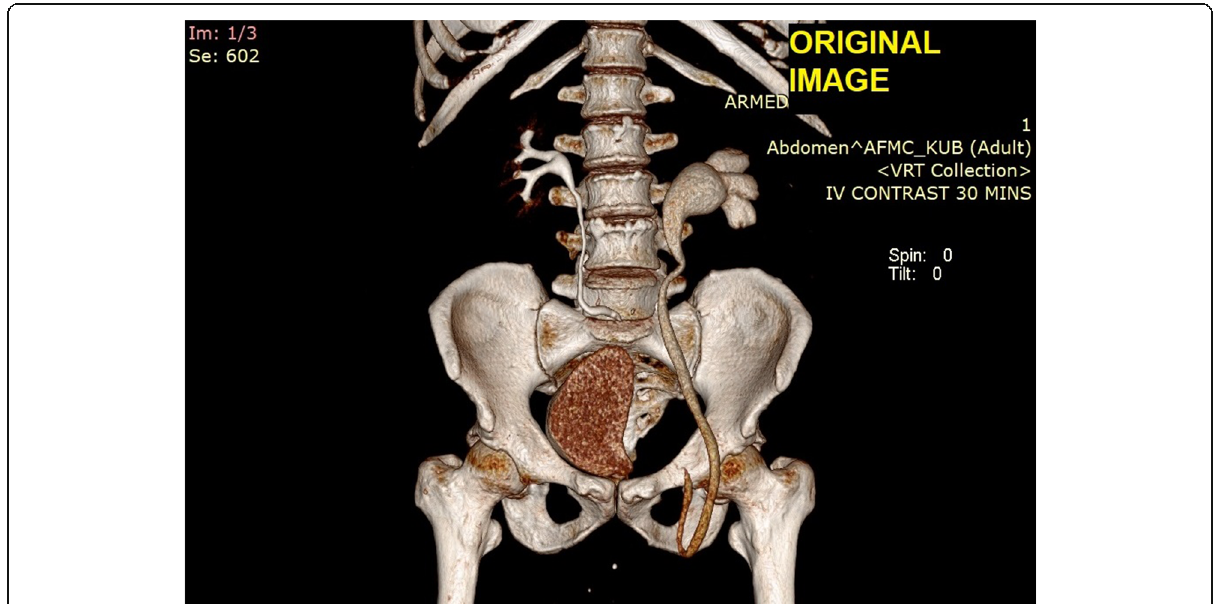
Fig. 3 Volume rendered image (VRI) of the left inguinal hernia sac with left ureter inside, in the pyelographic